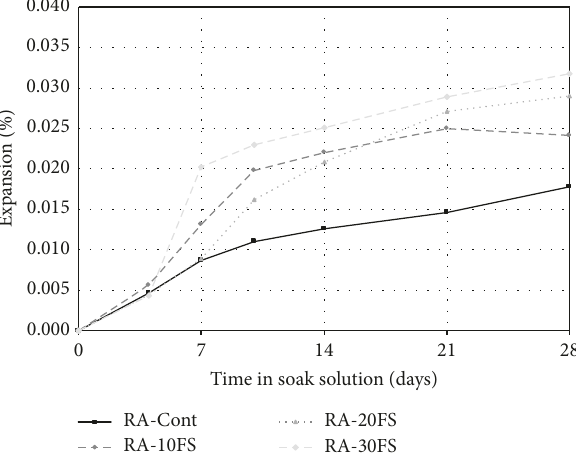
Figure 4: Expansion curves of reactive sand: foundry sand mix-